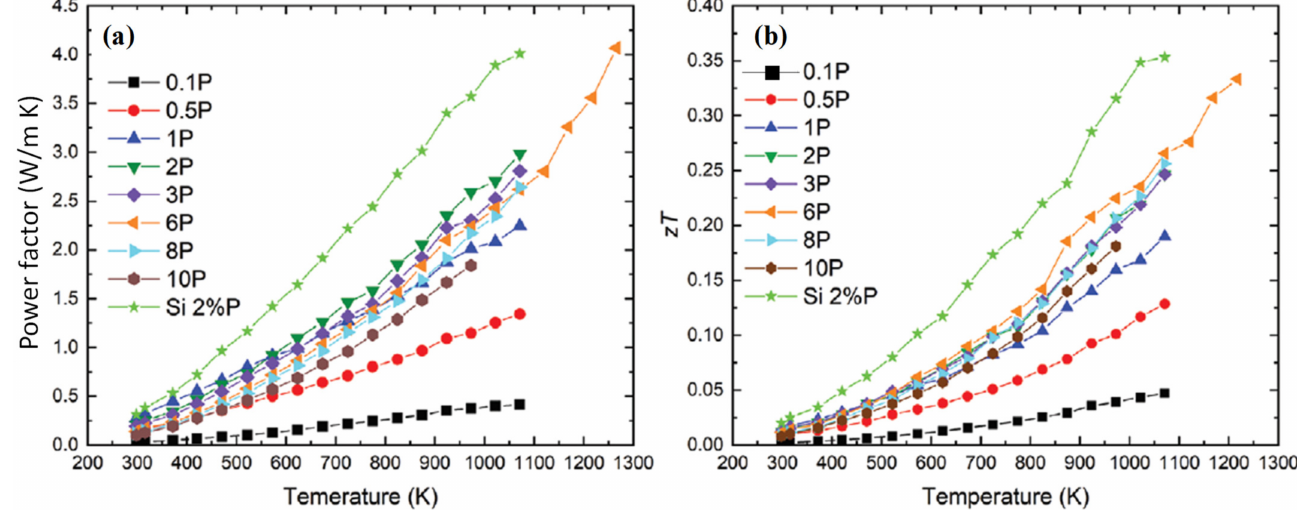
Figure 5. ( a ) Power factor and ( b ) figure of merit zT for silicon from sawing waste, with different levels of P doping. Figure from Ran et al.